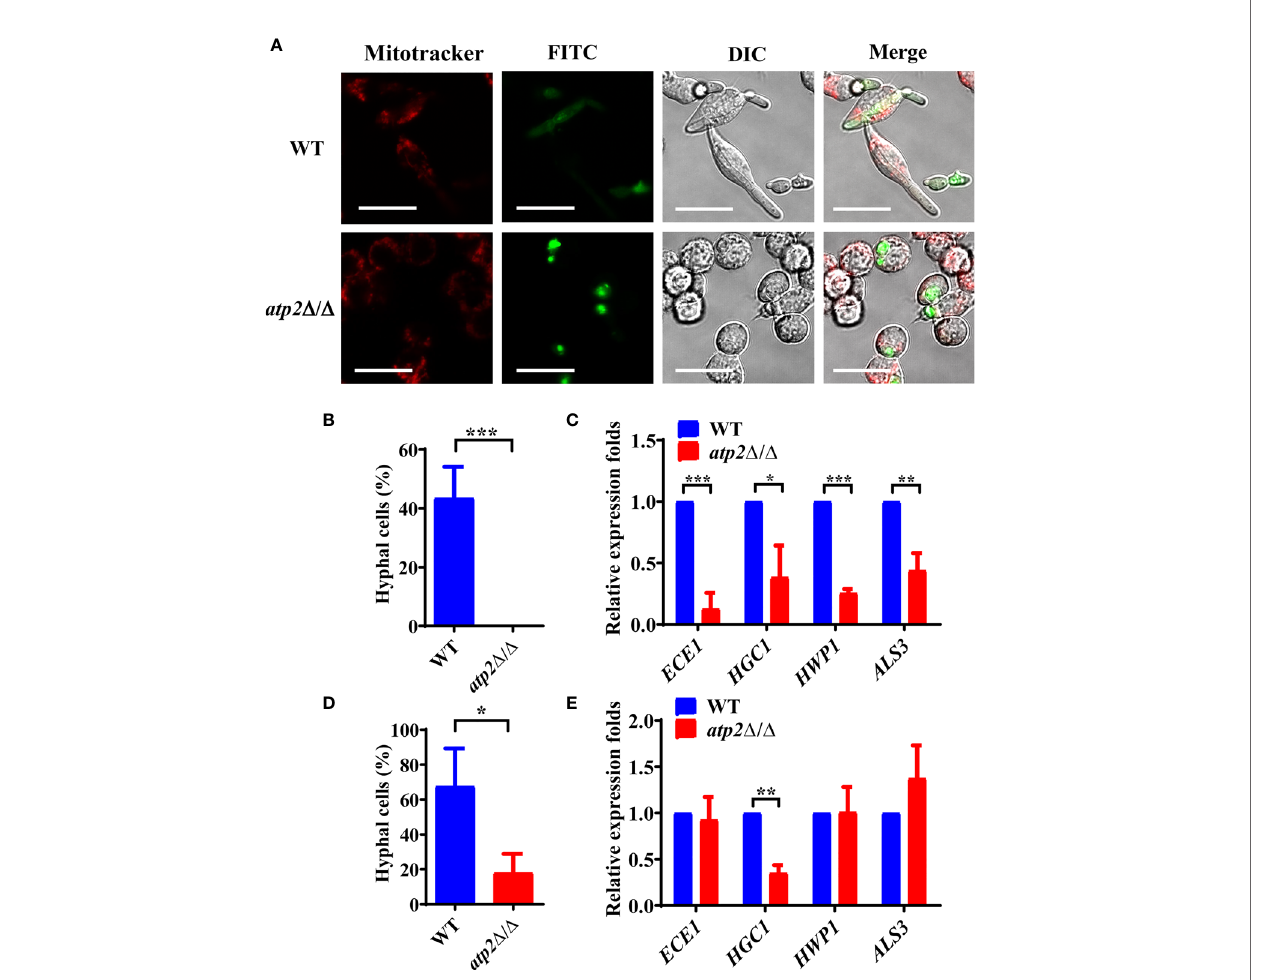
FIGURE 6 | Hyphae formation of C. albicans inside and outside of the macrophages. (A) Representative images of FITC-stained WT and atp2 D / D cells (green) co- cultured with MitoTracker Deep Red-preloaded RAW264.7 (red) at a 1:1 ratio for 3 h. Images were obtained by confocal laser scanning microscopy at channels E x644 /E m655 , E x488 /E m525 and DIC, ×630. (B, D) The percentage of hyphal cells inside (B) and outside (D) macrophages was calculated from 50 cells each group. (C, E) The relative expression level of hyphal-related genes in WT and atp2 D / D inside (C) and outside (E) macrophages after cocultured for 5 h. In (A) , one representative experiment of three independent experiments is shown; scale bars, 20 µm. In (B – E) data are shown as mean ± s.d. * P< 0.05, ** P <0.01, *** P <0.001; by Student ’ s t